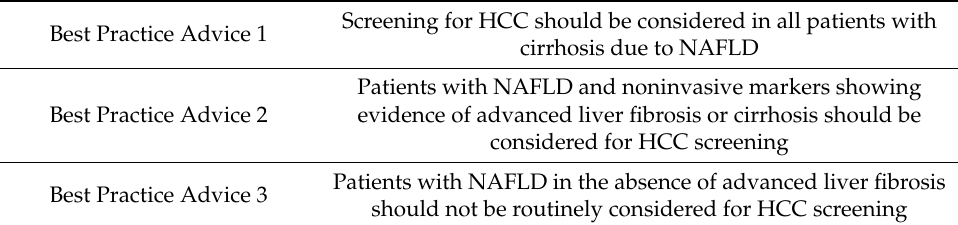
Table 2. Summary of the recommendations for HCC surveillance in nonalcoholic fatty liver disease [29]. Screening for HCC should be considered in all patients with Best Practice Advice 1 cirrhosis due to NAFLD Patients with NAFLD and noninvasive markers showing Best Practice Advice 2 evidence of advanced liver fibrosis or cirrhosis should be considered for HCC screening should not be routinely considered for HCC